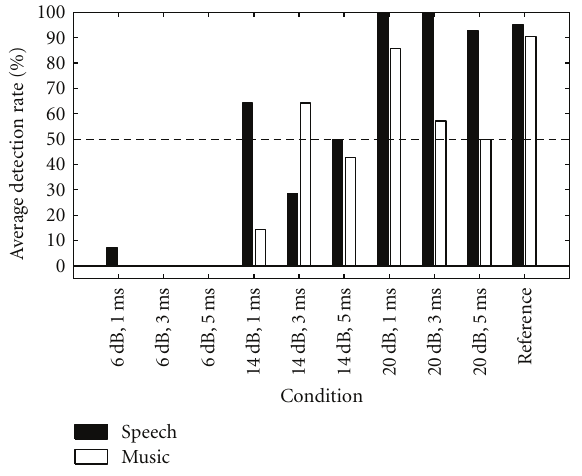
Figure 21: Results of the listening